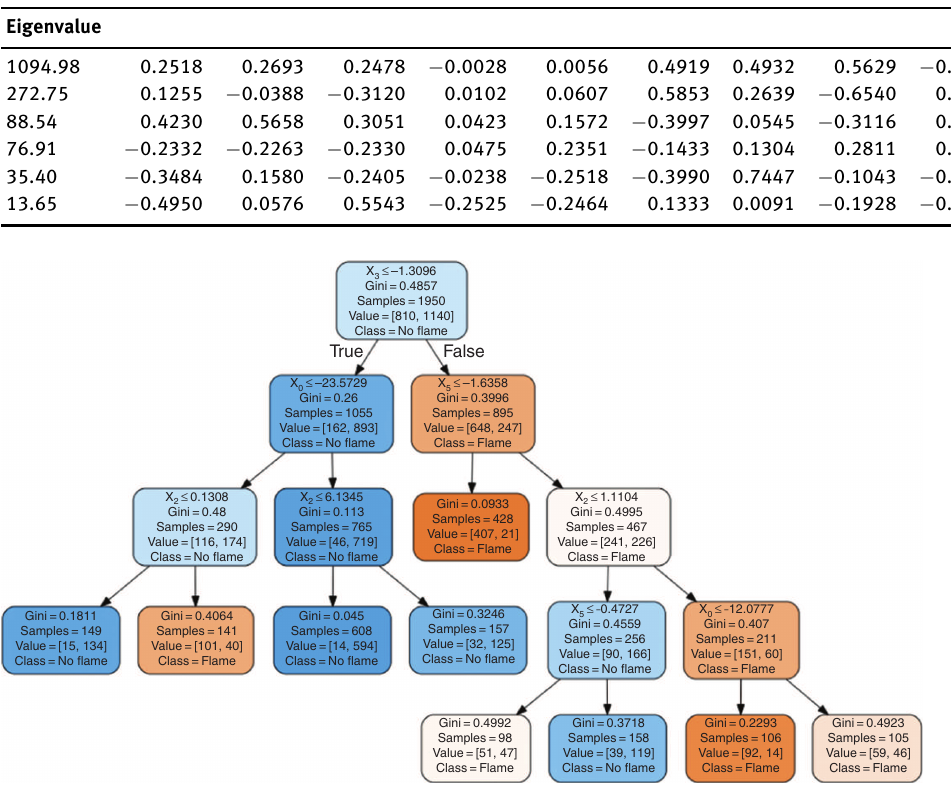
Figure 11: Final Decision Tree in Our